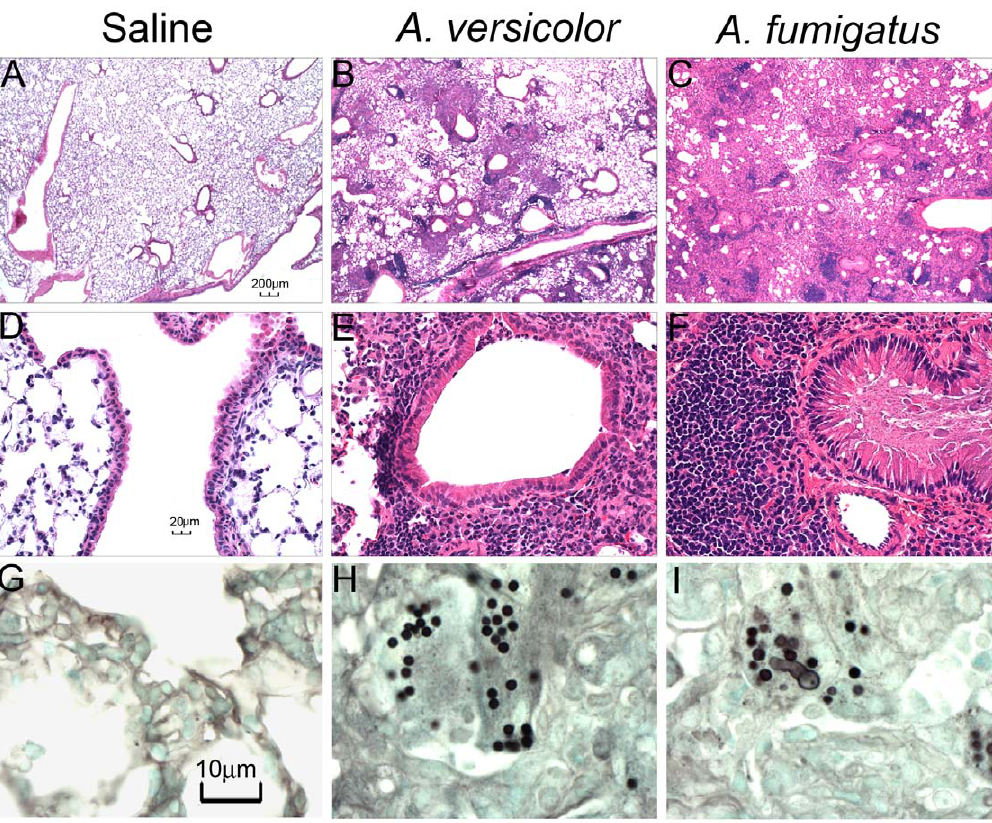
Figure 3. Lung histopathology and germination of conidia in mice exposed to Aspergillus conidia. A–F, H&E staining of mouse lung tissue. G–I, GMS staining of lung tissue. A,D,G, saline controls. B,E,H, A. versicolor , C,F,I, A. fumigatus . A–C 4 6 magnification, D–F, 40 6 magnification. G– I, 100 6 magnification. Data depicted are representative samples of 5 mice per group with one lung section analyzed per animal.